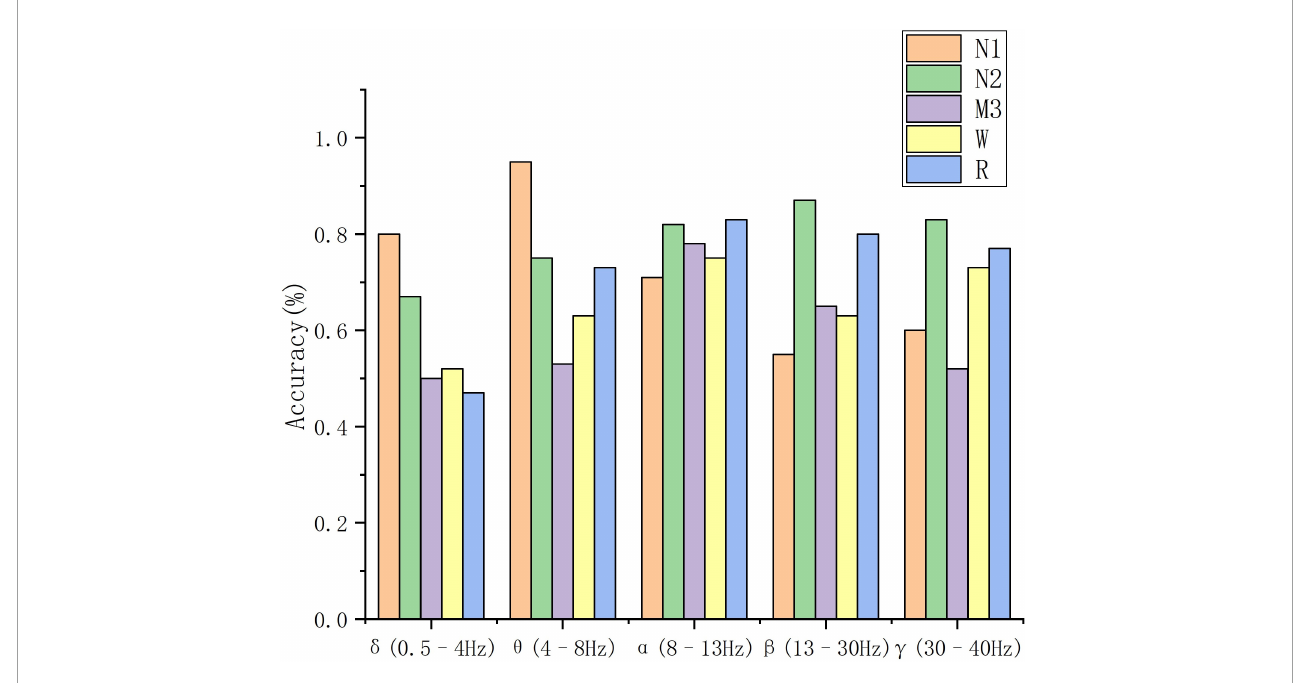
FIGURE5 The results of the 5-band EEG direct feature extraction for 5 types of sleep